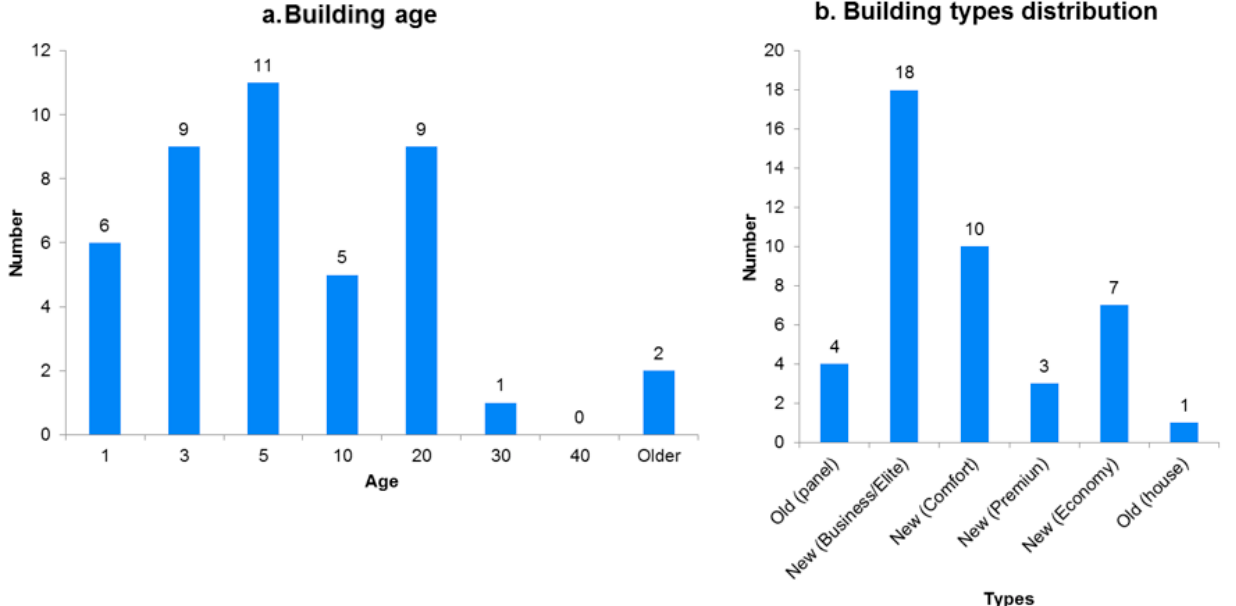
Figure 2. ( a ) Building age distribution histogram; ( b ) building type